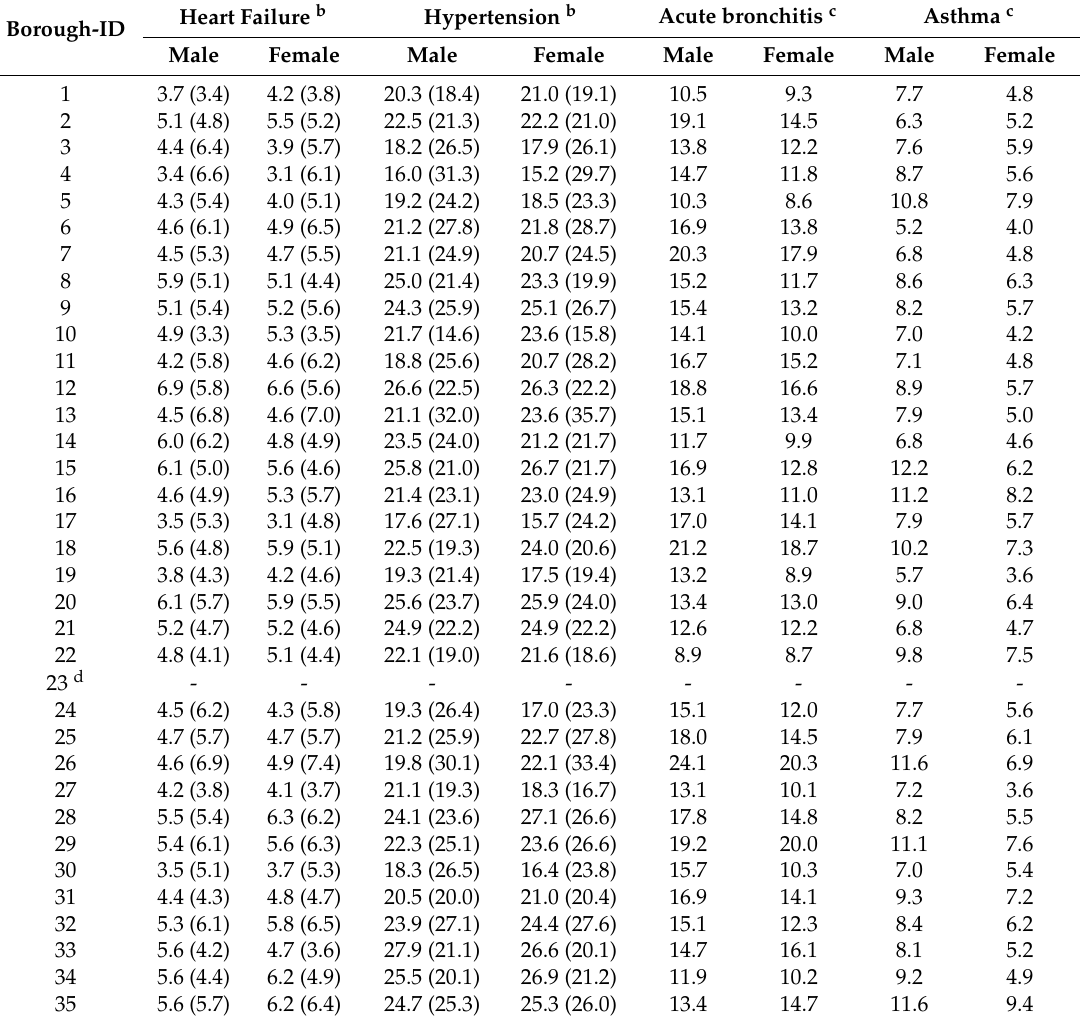
Table A2. 1-year-prevalence rates (%) and age-standardized prevalence rates (%, in brackets) per borough-ID, Hamburg, Germany (2011) a